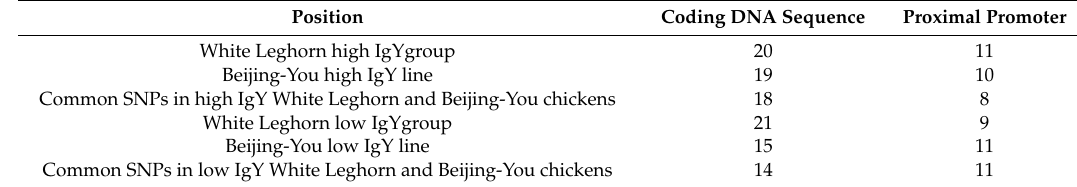
Table 7. Number of non-synonymous SNPs in the coding DNA sequences and proximal promoter regions.